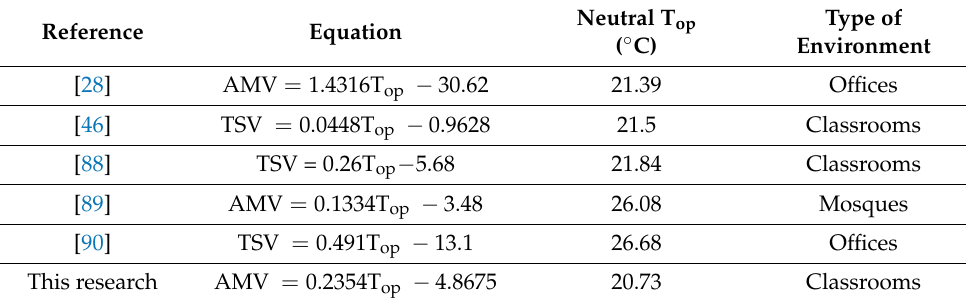
Table 7. Relationship between T op and AMV.